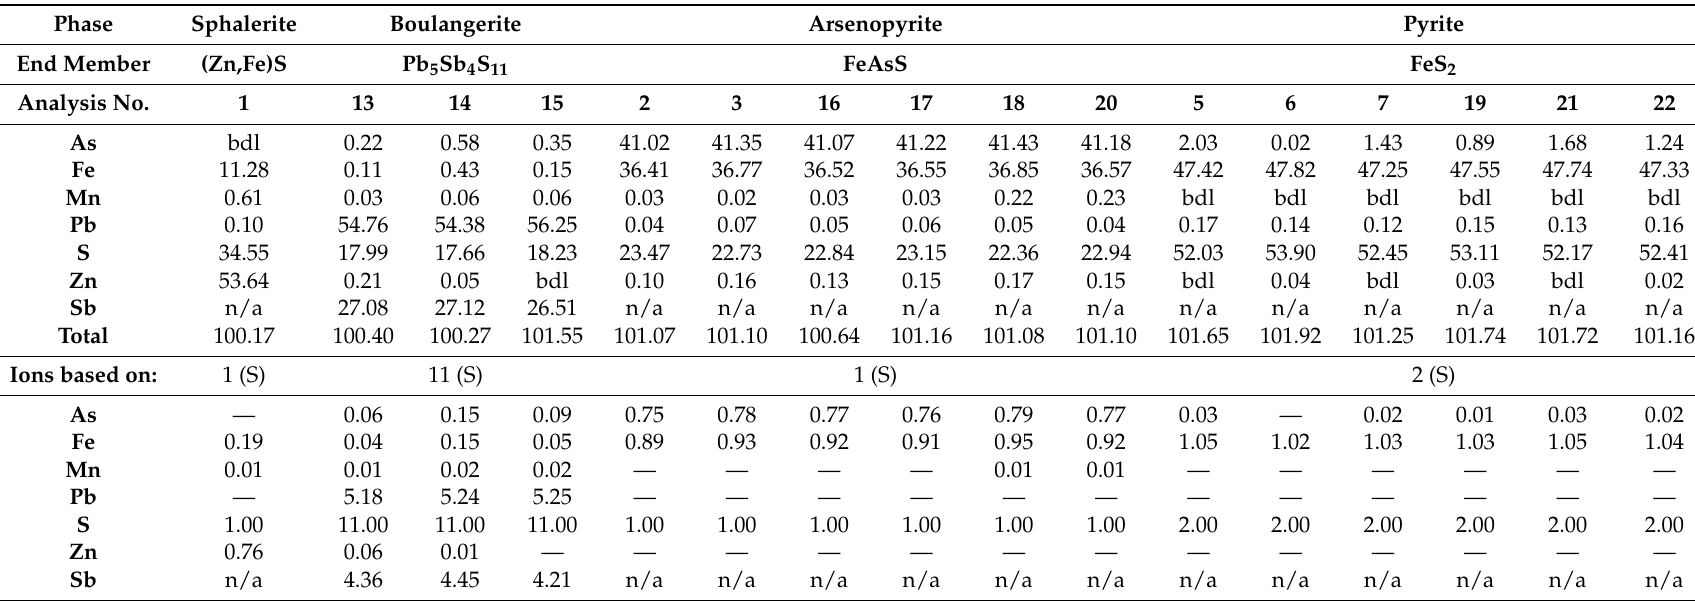
Table 3. EPMA analyses of mineral phases present in Olympias Py-AsPy concentrate (bdl: below detection limit, n/a: not